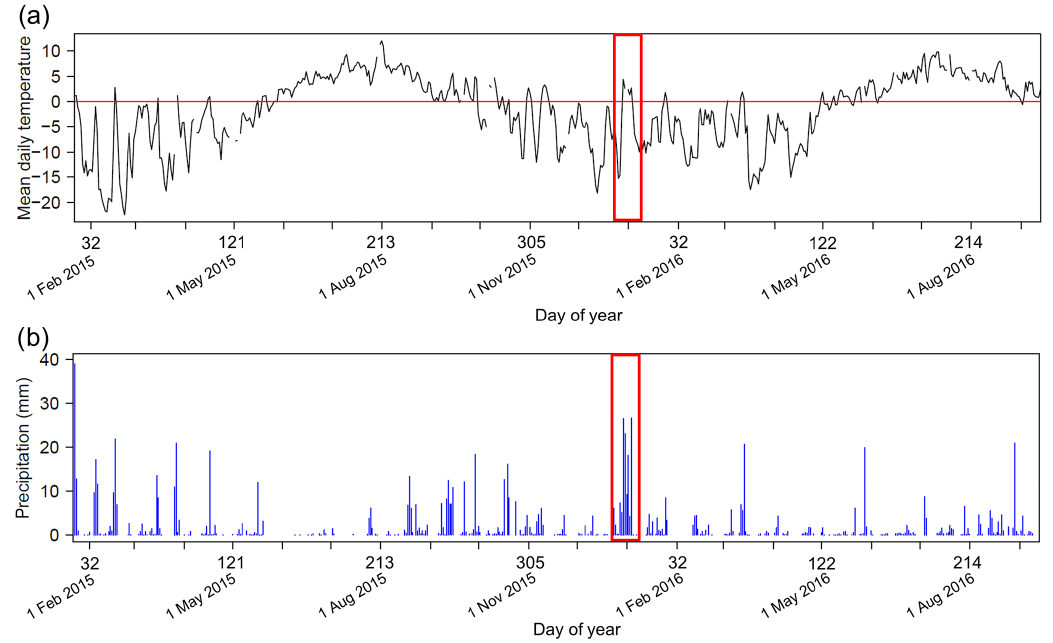
Figure A2. (a) Temperature and (b) precipitation record from the meteorological station at Ny-Ålesund (ID 99910, 8ma.s.l.) from 22 Jan- uary 2015 to 13 September 2016 (DOY 22 2015 to 257 2016). The red box indicates the time of the winter rain event with wet and warm conditions, triggering low backscatter intensity of the snow and firn in upper parts of Kongsvegen on the 5 January 2016 SAR image. Af- ter the rain event, but during the same weather situation, the precipitation might have turned into snow on the glacier (downloaded from eKlima.no,